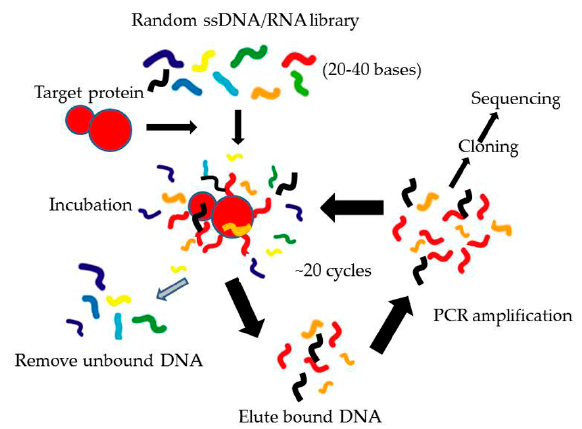
Figure 2. Process of conventional Systematic Evolution of Ligands by EXponential enrichment (SELEX). Different sequences of ssDNA/RNA are shown in different color.